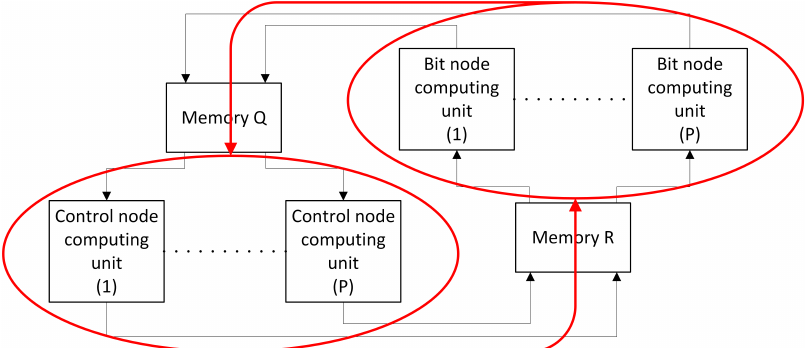
Figure 3. General idea of token passing in the designed partially-parallel QC-LDPC decoder